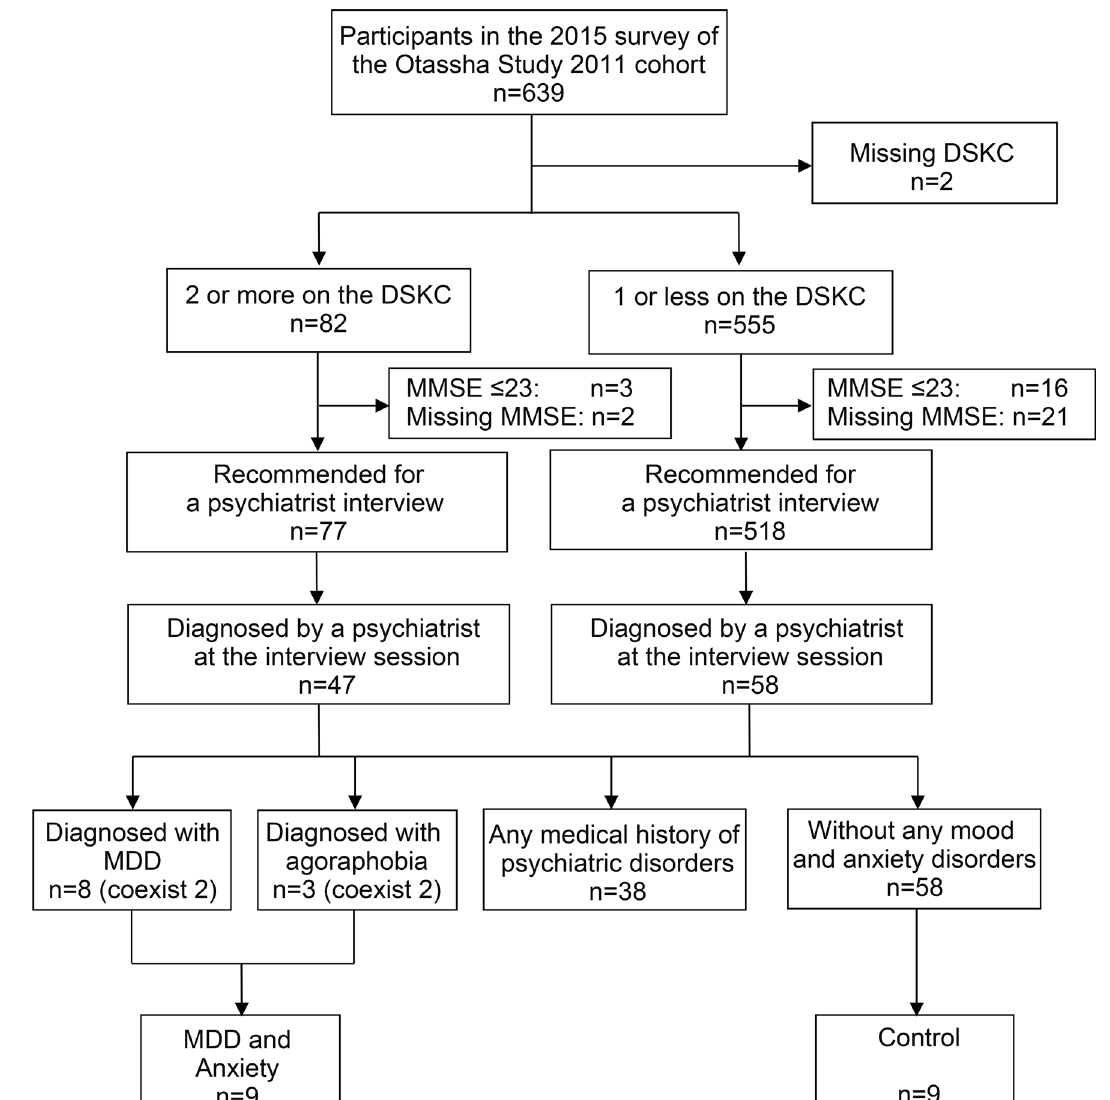
Fig. 1 Flowchart for identifying persons suffering from major depressive disorder (MDD) and/or agoraphobia disorders DSKC the depression section of the Kihon Checklist, MMSE the Mini-Mental State